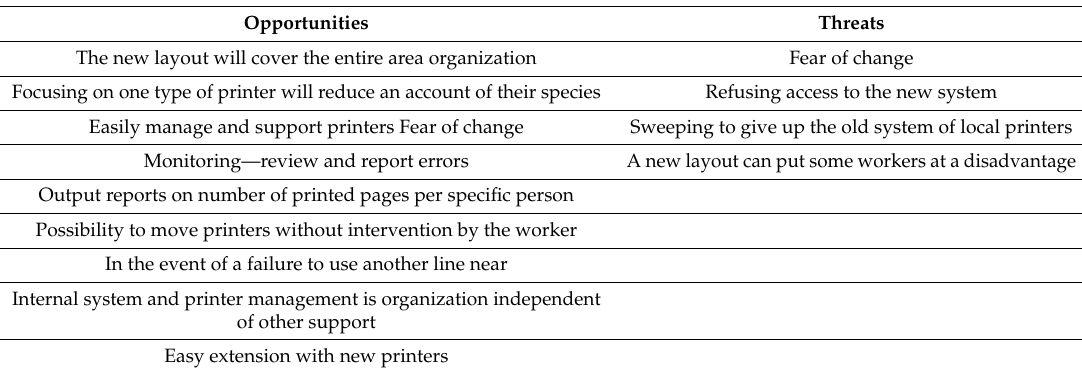
Table 5. Opportunities and